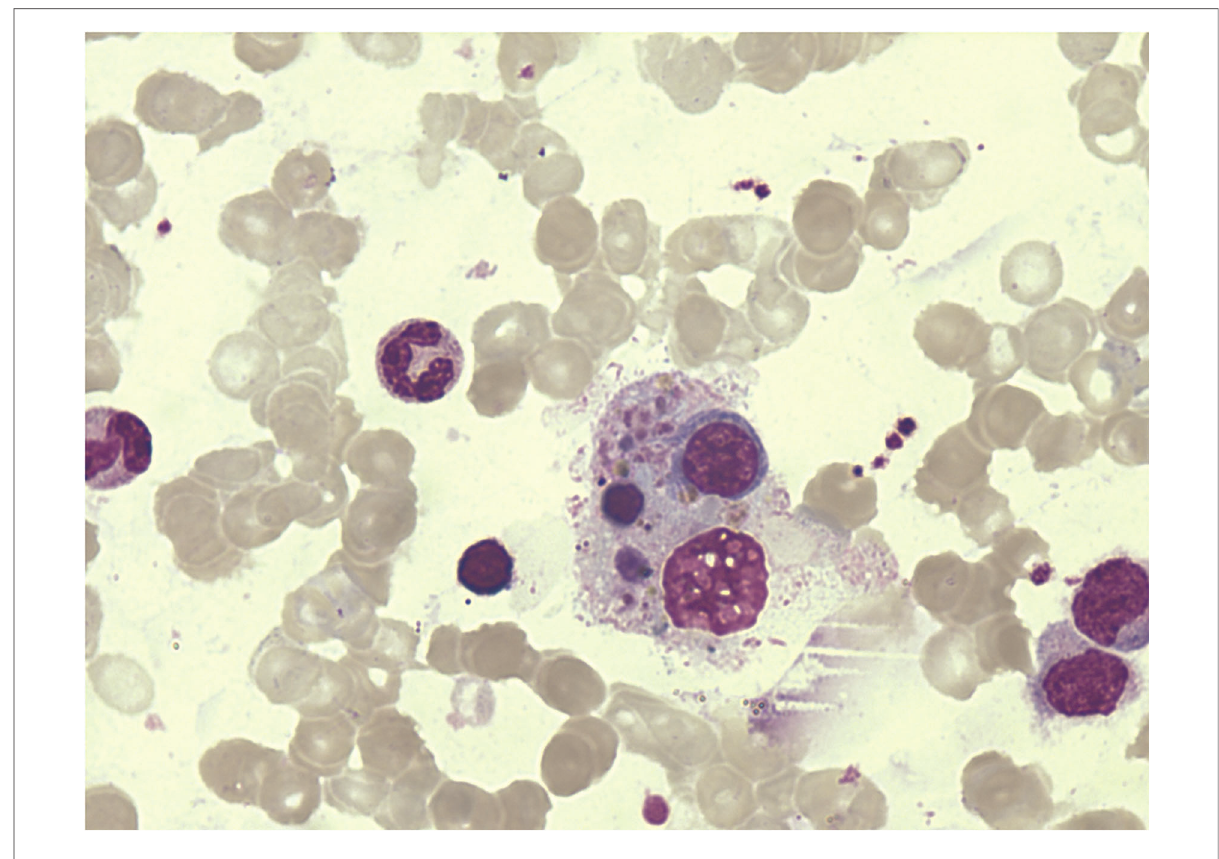
FIGURE 2 Hemophagocytic cells found in bone marrow